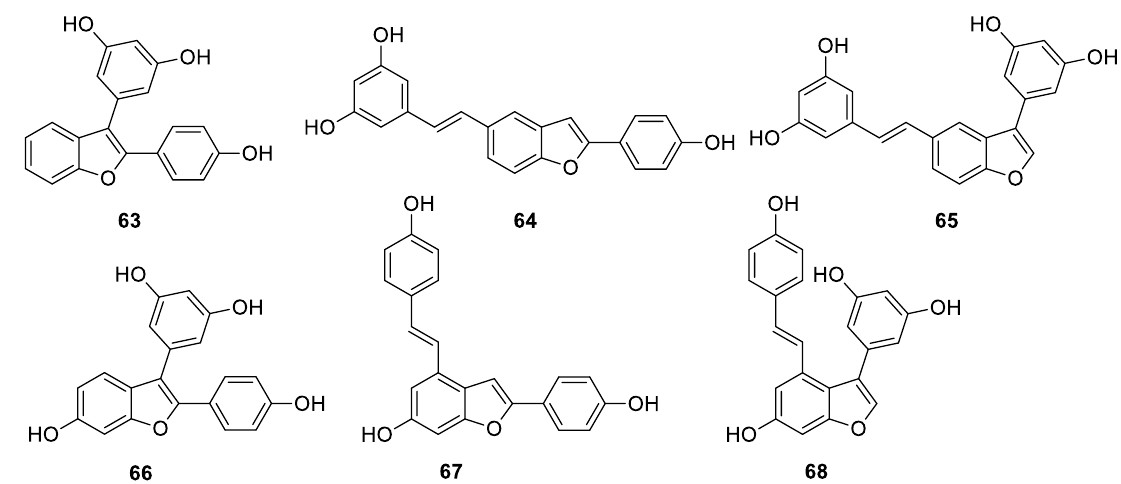
Figure 20. Structures of benzofuran derivatives of δ - and ε -viniferin from Catinella et al. (2020) [115].